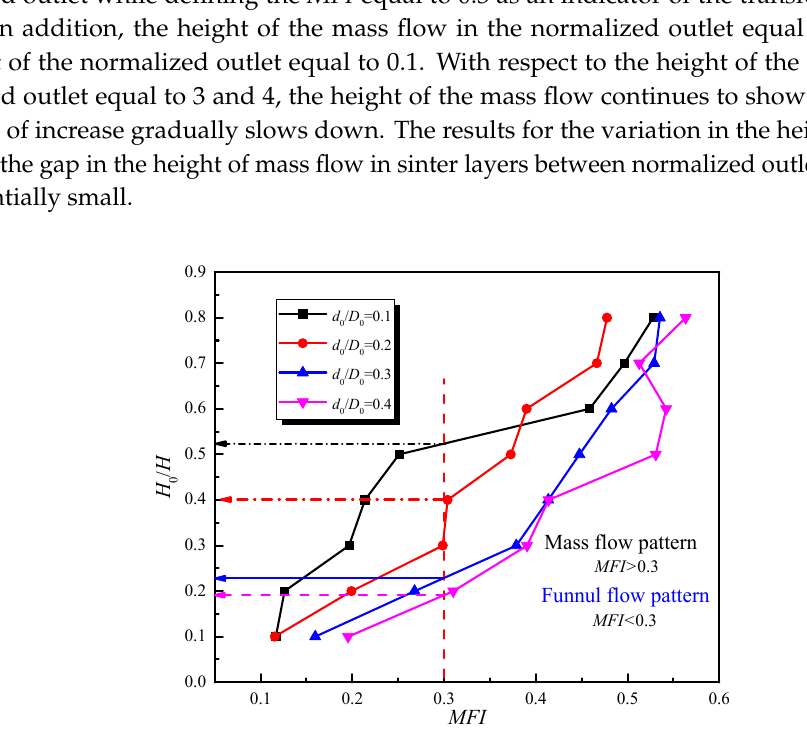
Figure 11. The evolution of sinter layer velocity along the vertical direction with different normalized outlet scales.